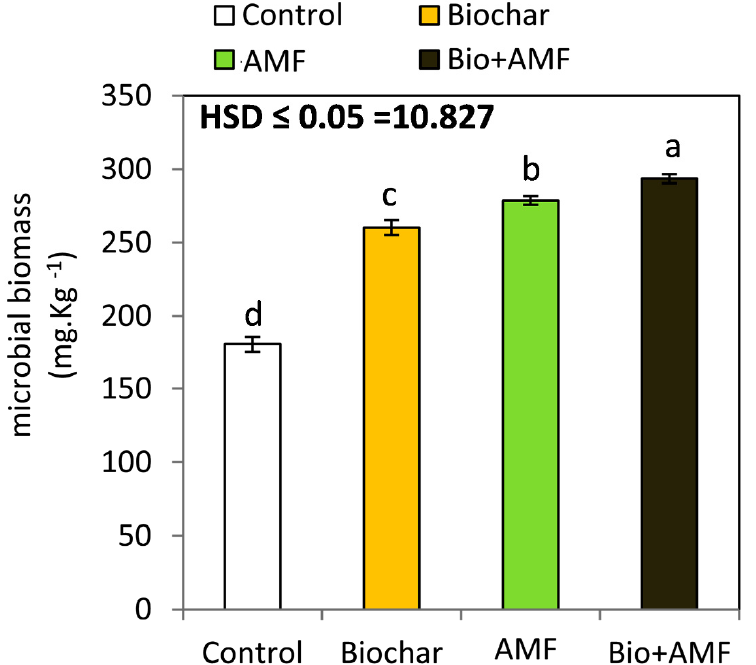
Figure 4. Impact of biochar and AMF on the microbial biomass in soil. Data are means of five replicates ( n = 5), and for each parameter, the mean values ± SD followed by a different letter are significantly different according to Tukey’s HSD range test at p ≤ 0.05.